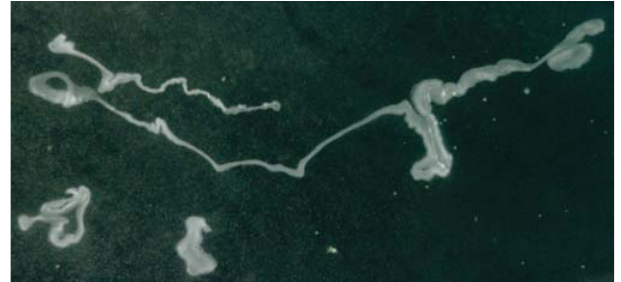
Figure 1. Trichoplax adhaerens Individuals Creeping along the Glass Wall of an Aquarium The nearly “rounded up” individual in the lower center of the image is several millimeters long. Extremely elongate forms such as these are often seen in large aggregations of Trichoplax individuals.